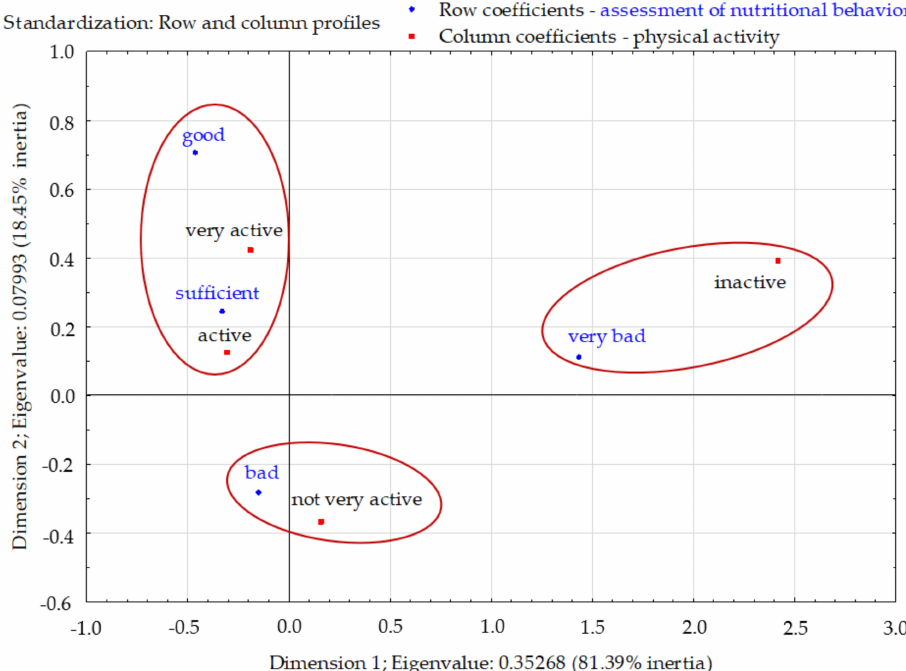
Figure 3. Assessment of nutritional behavior of young Poles and their physical activity (correspon- dence analysis). Source: own study based on the